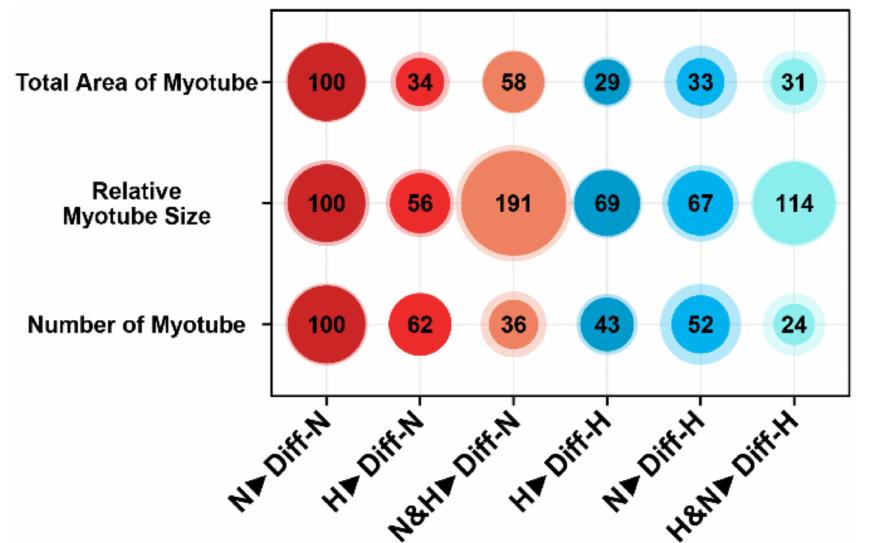
Figure 5. Bubble plots of all investigated groups normalized to N (cid:183) Diff-N. Mixed cell cultures showed the greatest relative myotube size, independent of their oxygen environment, even though the number of myotubes was decreased compared with the other groups. Despite low number of myotubes, the total area was greater within N&H (cid:183) Diff-N compared with all other